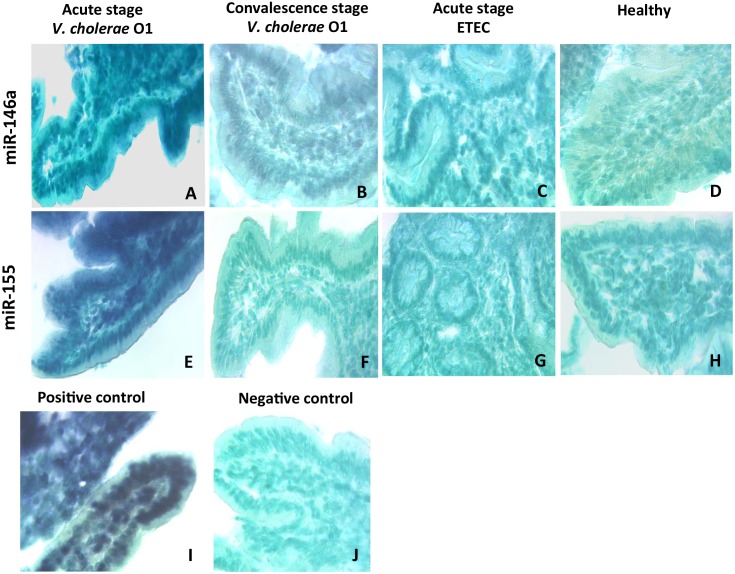
miR-146a and miR-155 are expressed in the epithelium and lamina propria of duodenal mucosa in patients with V. cholerae O1 infection at the acute stage.In situ hybridization was performed on sections of frozen duodenal mucosa using digitonin-labeled locked nucleic acid (LNA) microRNA detection probes. Micrographs are representative of miR-146a (A—D) and miR-155 (E—H) staining of duodenal mucosa from one patient with V. cholerae O1 infection at acute (A, E) and convalescent (B, F) stage of disease, one patient with ETEC infection at acute stage (C, G) and one healthy control (D, H). I and J show the technical positive and negative control when staining of duodenal mucosa of the patient with V. cholerae O1 infection at the acute stage with a probe for U6 small nuclear RNA (I) and a scrambled microRNA-probe (J). Original magnification: ×400.